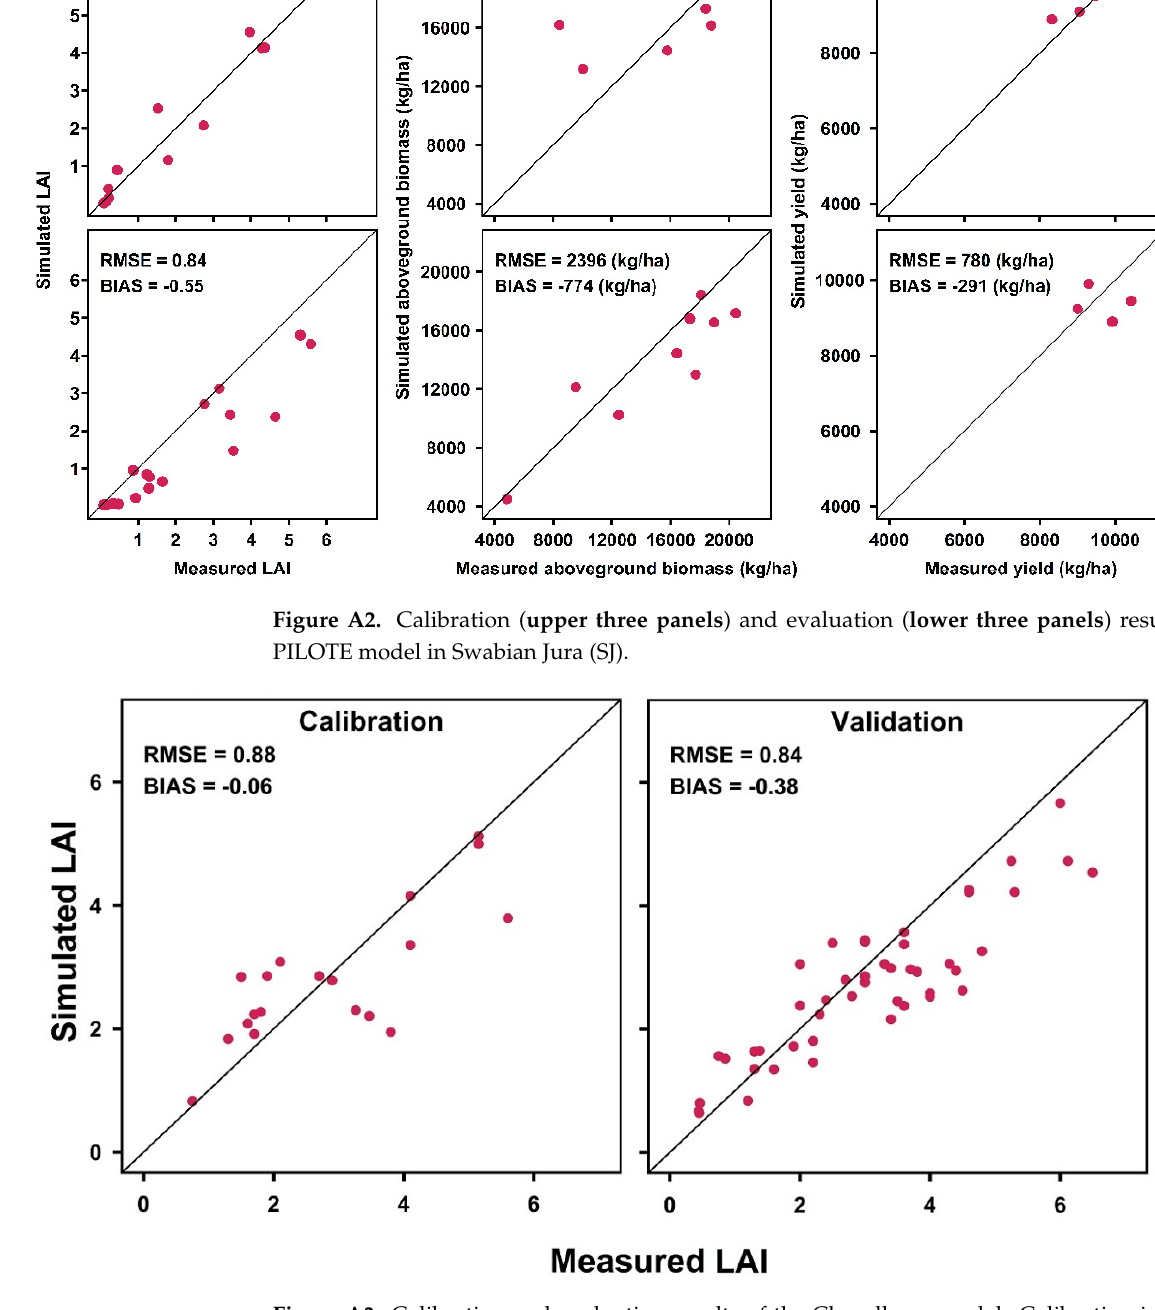
Figure A3. Calibration and evaluation results of the Choudhury model. Calibration is based on site-years from 2010 to 2013, evaluation on the remaining site-years.